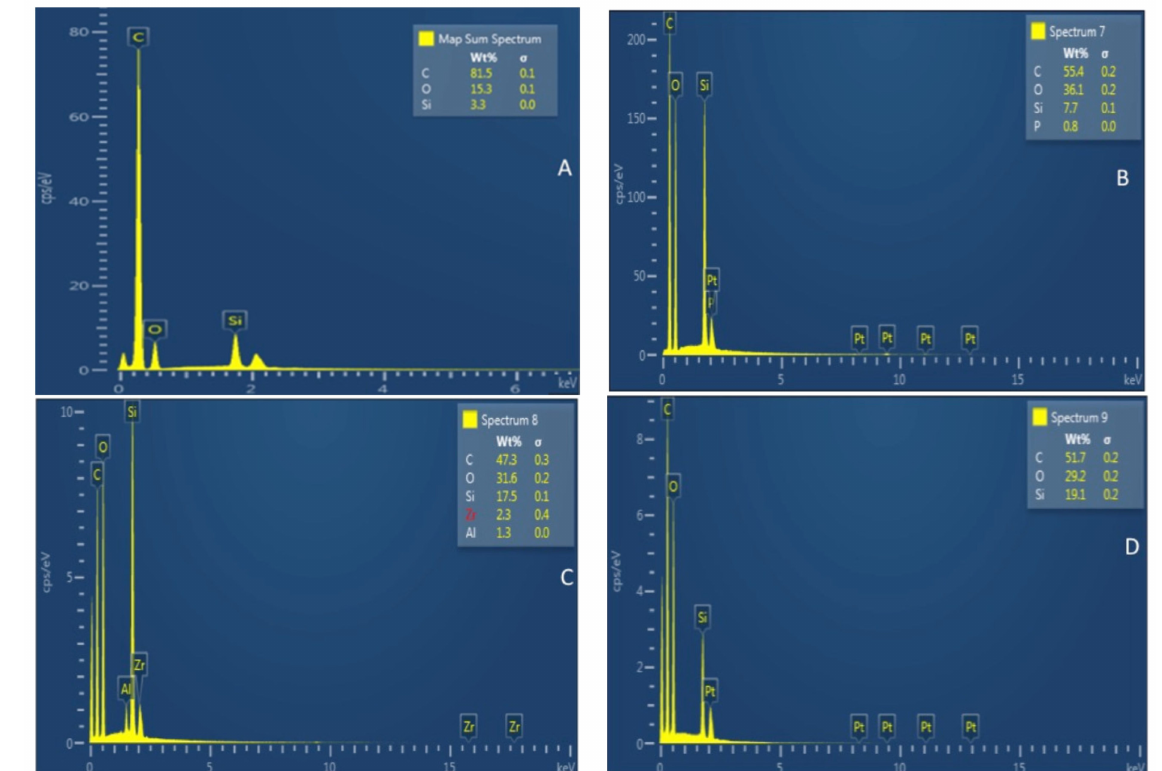
Figure 3. Energy dispersive X-ray spectroscopy (EDX) analysis of ( A ) unfilled adhesive (Si-EA-0%) ( B ) 5% silica-filled adhesive (Si-EA-5%) ( C ) 10% silica-filled adhesive (Si-EA-10%) and ( D ) 15% silica-filled adhesive (Si-EA-15%). Note the highest amount of silica (19.1%) in the 15% silica-filled adhesive as compared to the other groups with a low weight percentage of silica.